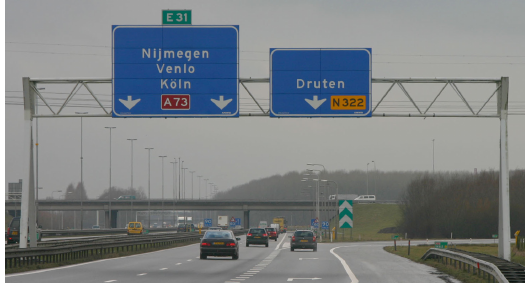
Figure 1. A typical traffic sign gantry on a Dutch highway with in the background a highway viaduct. The horizontal clearance is restricted by guard rails on both sides of the road. (Source: Rijkswaterstaat,